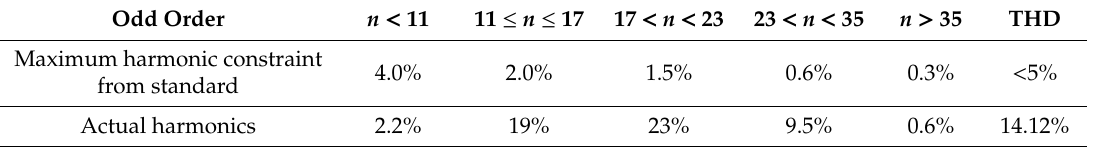
Figure 2. ( a ) Current before and after filtering (left); ( b ) FFT harmonic before and after filtering (right). Table 1. Harmonic constraint standard and actual harmonic of grid.